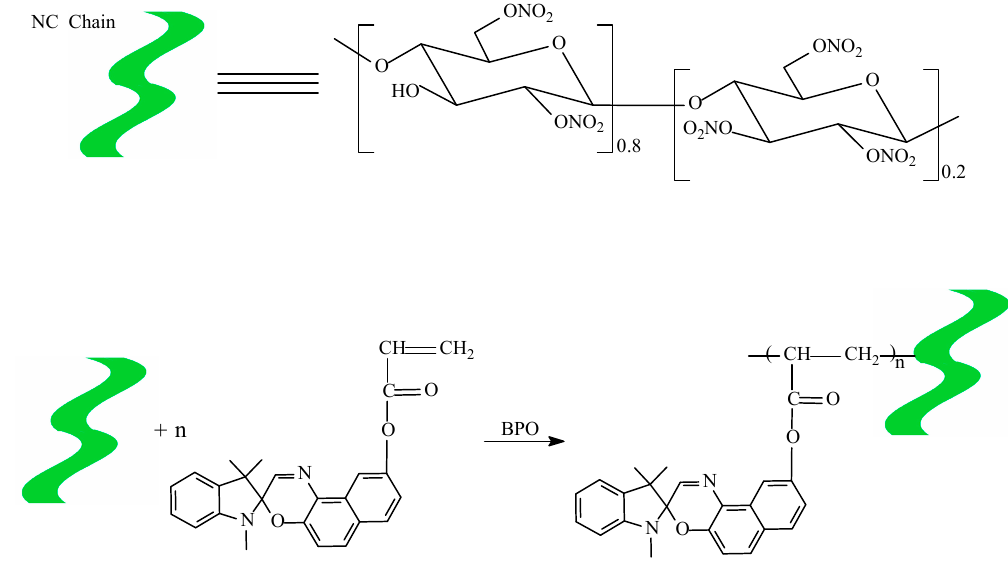
Figure 2. Synthetic route to NC-g-AISO.